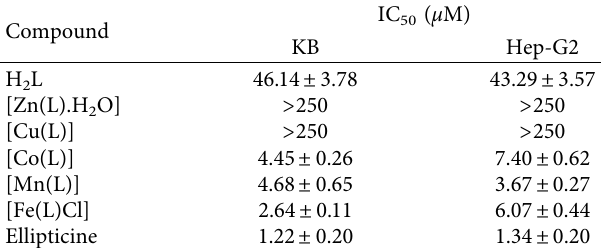
Table 2: Cytotoxicity of H